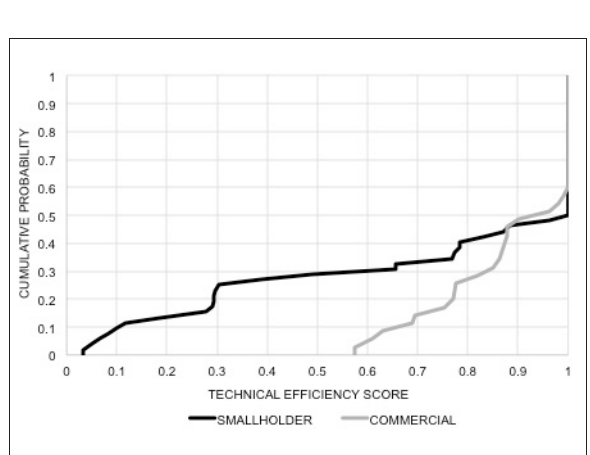
Figure 1: Cumulative probability of smallholder and commercial tomato farmers’ technical efficiency scores.